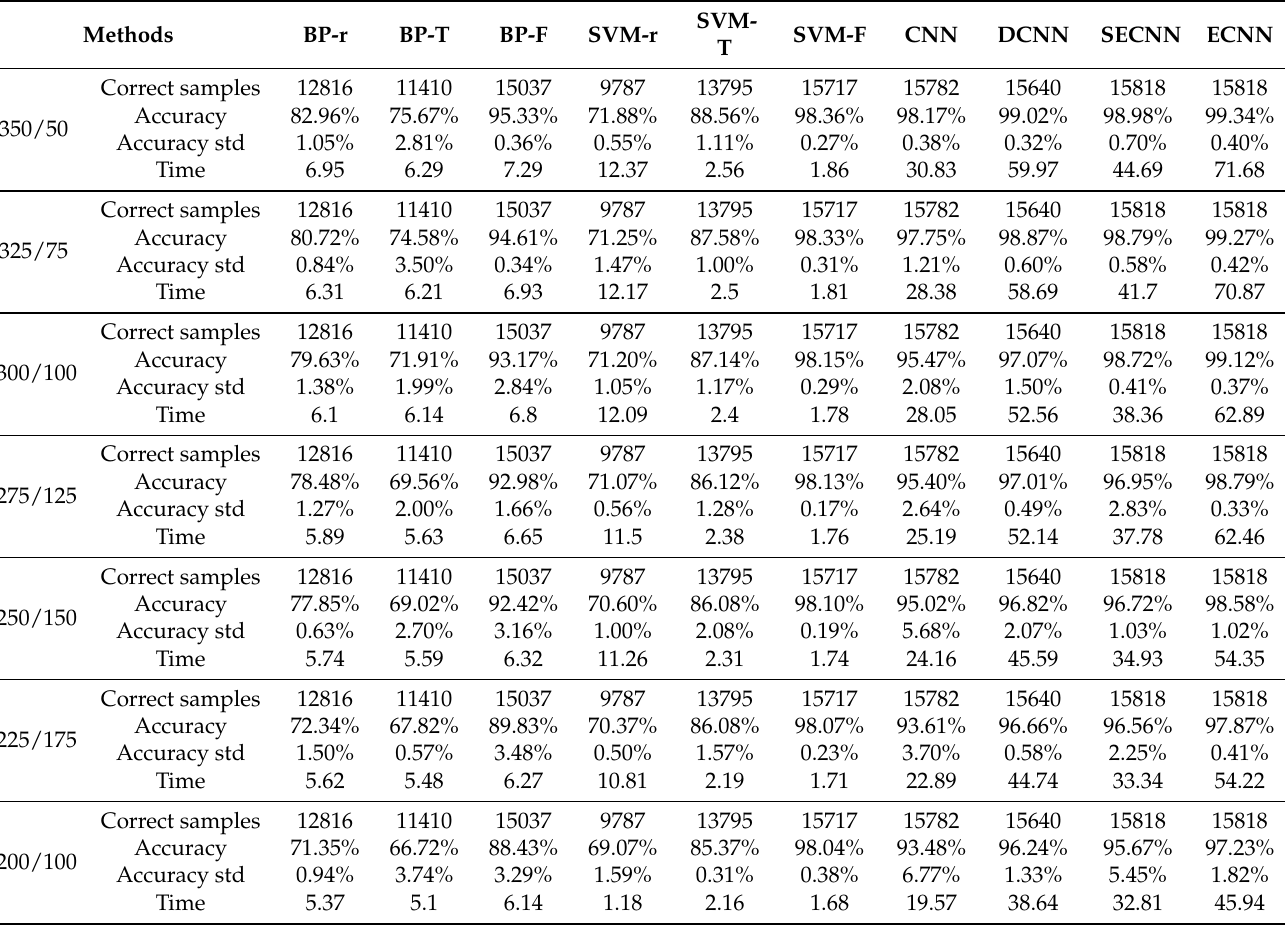
Table 4. Accuracy of different segmentation ratios.